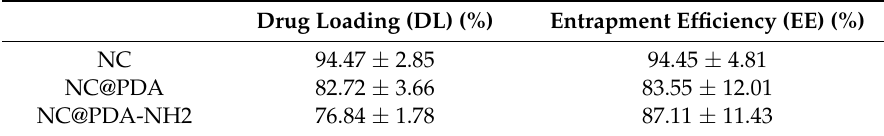
Table 1. Drug loading (DL) and entrapment efficiency (EE) for nanocrystal (NC), polydopamine (PDA)-coated NC (NC@PDA), and amino-group-functionalized NC@PDA (NC@PDA-NH 2 ) ( n = 3, mean ± SD).